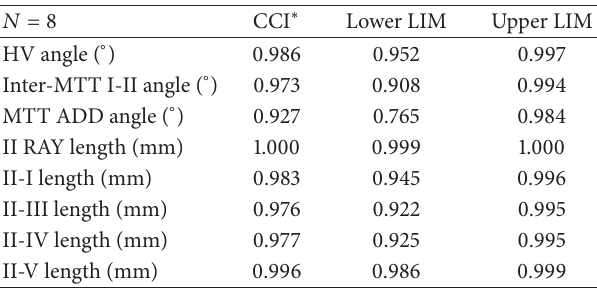
Table 5: Intraclass coefficient of correlation